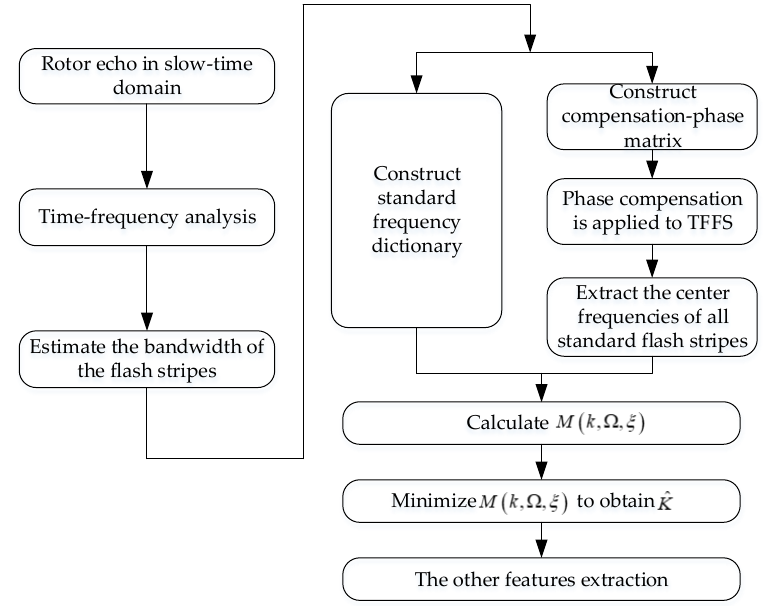
Figure 5. The flowchart of the proposed method.